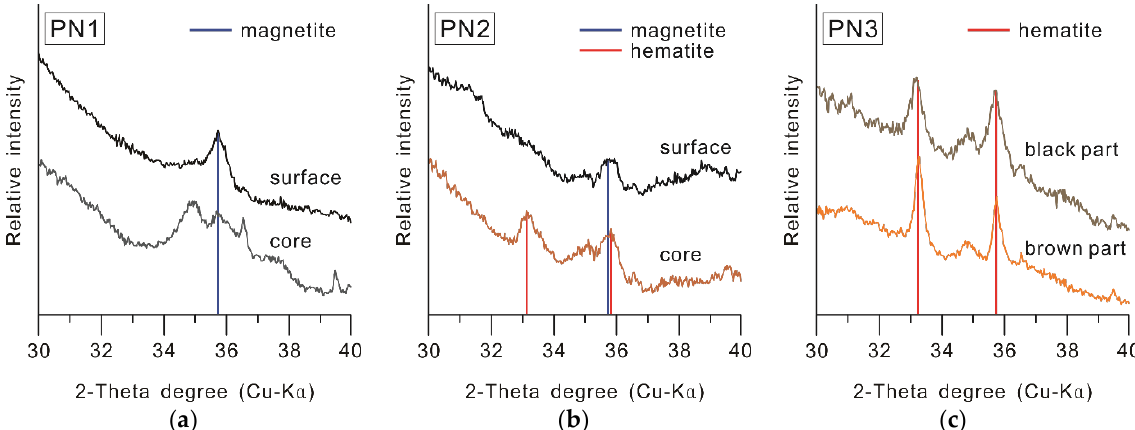
Figure 5. X-ray diffraction patterns with enlarged iron oxide peak area of the oriented samples of clay particles: ( a ) PN1, ( b ) PN2, and ( c ) PN3.